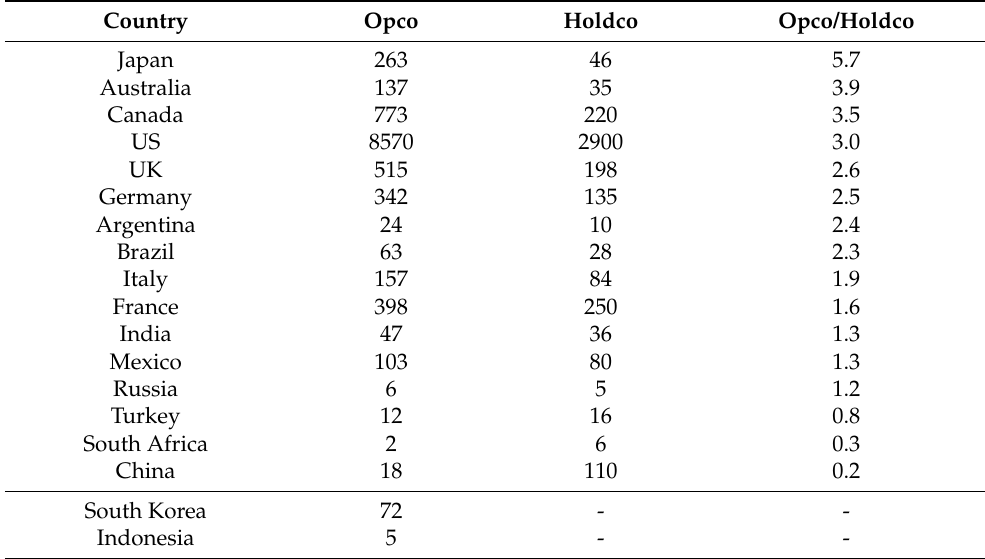
Table 9. OPCO—HOLDCO Comparisons with relative ratios in descending order Table prepared using 16 August 2021 data.